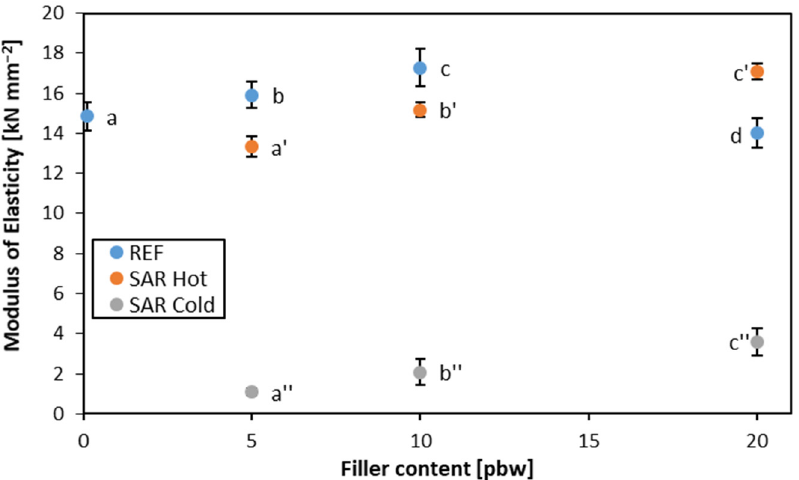
Figure 5. The modulus of elasticity of the plywood samples of different filler content (the letters on the plots indicate the homogeneous groups).